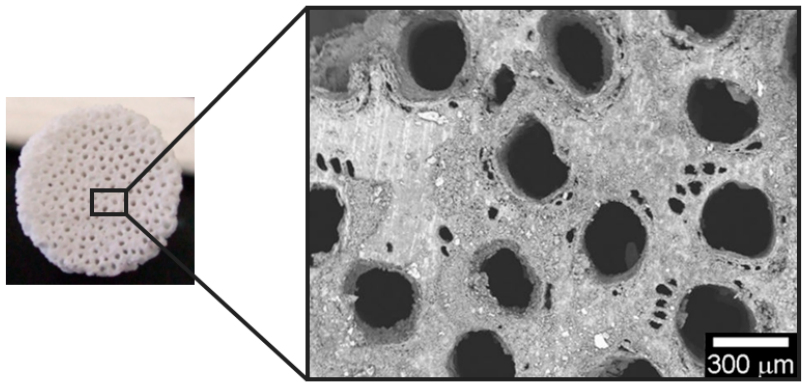
Figure 5. Hierarchically organized biomorphic scaffolds for regeneration of load-bearing bones ( left ) and SEM micrograph showing the macroscopic longitudinal channels mimicking the osteon ( right ).